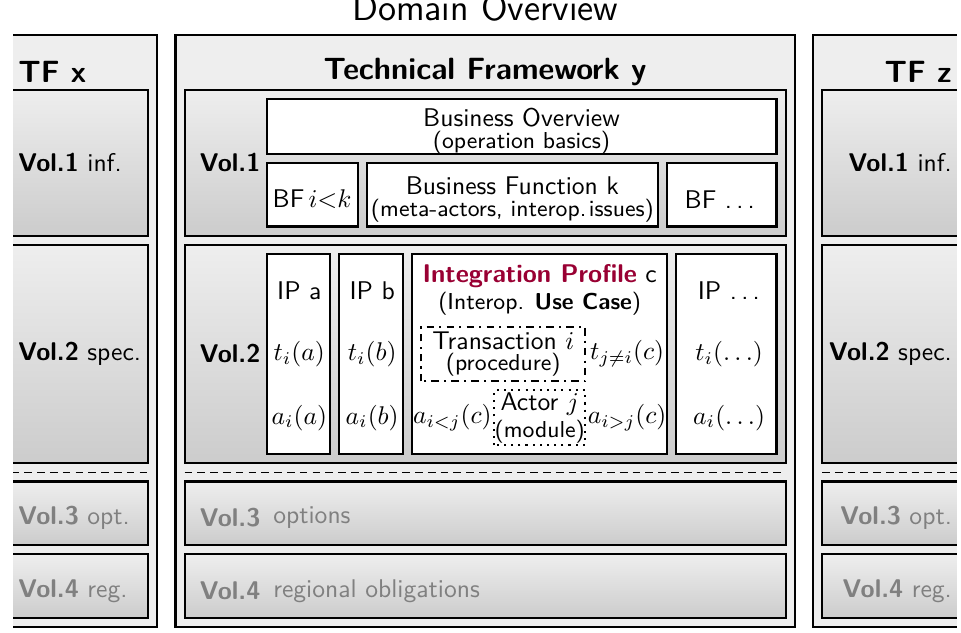
Figure 12. The Extended Document Structure: Technical Frameworks are collections of many parts, each assigned to a layer, that may be individually extended and adjusted following changing demands and the progress of technologies over